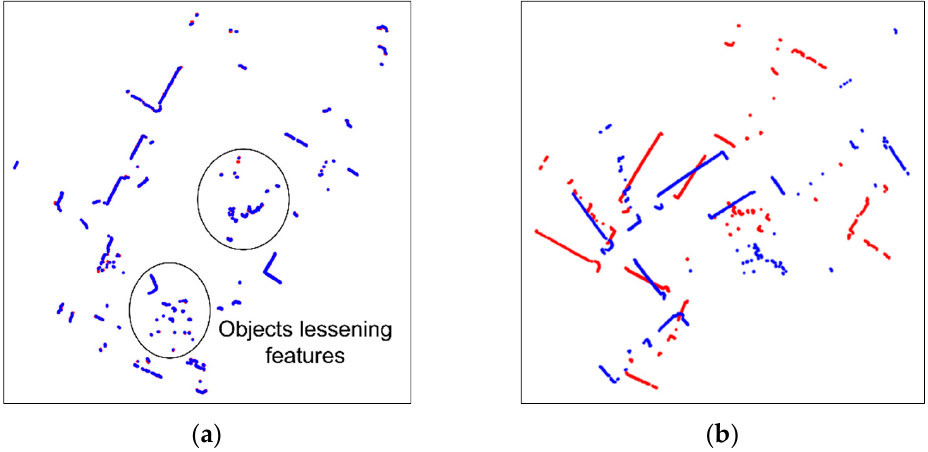
Figure 17. Scan matching images in environment 5 (Red: Previous scan, blue: current scan). ( a ) Normal matching images; ( b ) faulty matching images.